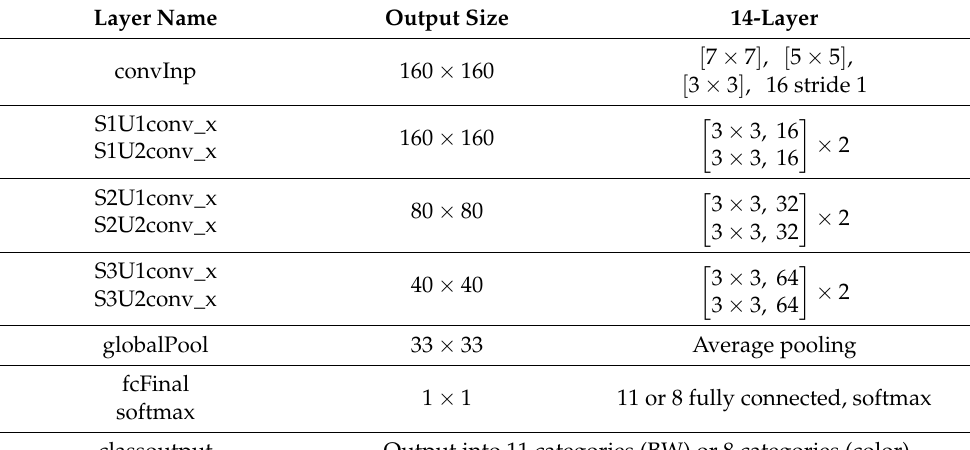
Table 9. Residual model’s